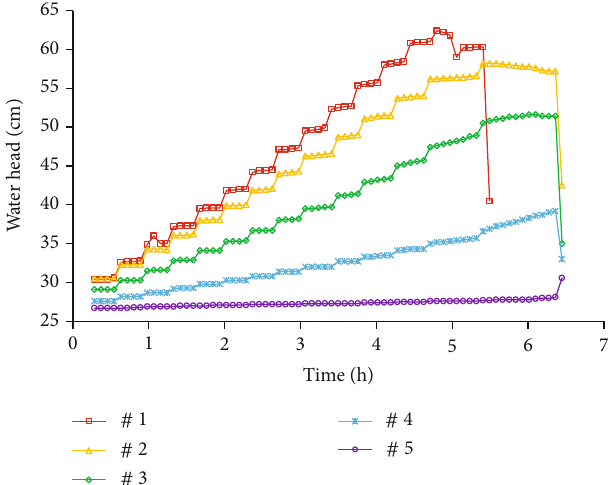
Figure 12: Process curve of water head of di ff erent piezometers located in soil numbered 2.